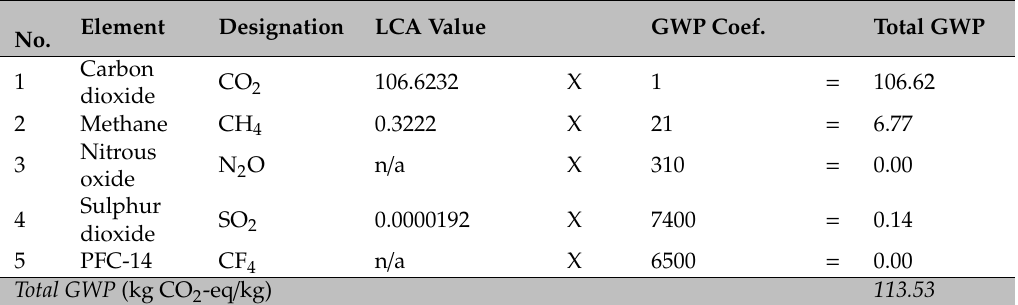
Table 15. Results for related gasses being aggregated into a single unit in terms of their impact as carbon dioxide equivalents for CR